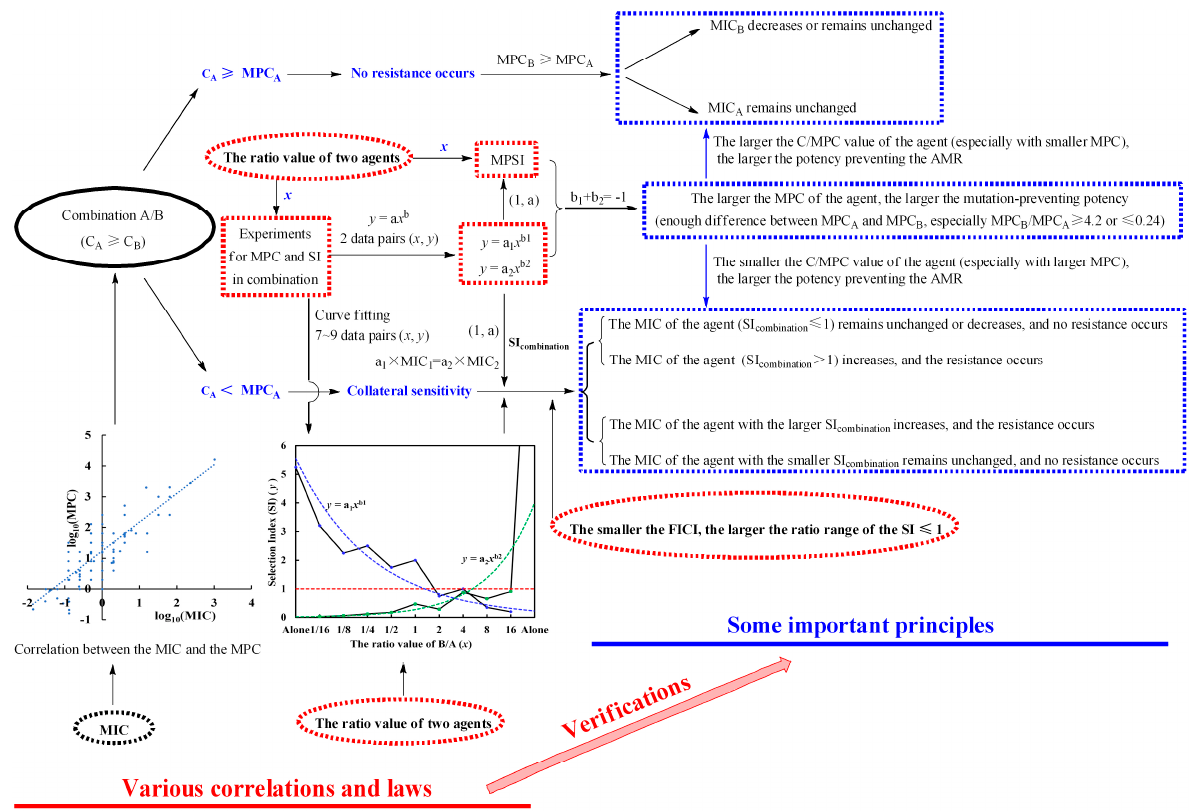
Figure 3. Diagram of the mutation-preventing effects and the resistant trajectories for drug combinations with different concentrations and ratios of two agents. Combination A/B consists of agents A and B, and C A and C B are the applied concentrations of agents A and B, respectively; MIC, minimal inhibitory concentration; MPC, mutant prevention concentration; FICI, fractional inhibitory concentration index; MPSI, mutation-preventing selection index; SI combination , the SI in combination of two agents; setting C A larger than or equal to C B , and MPC B larger than or equal to MPC A . As shown in Figure 3, to simultaneously prevent the resistance to two agents in combinations, the concentration of the agent with larger proportion should be applied larger than or equal to its MPC alone. Otherwise, the collateral sensitivity will probably